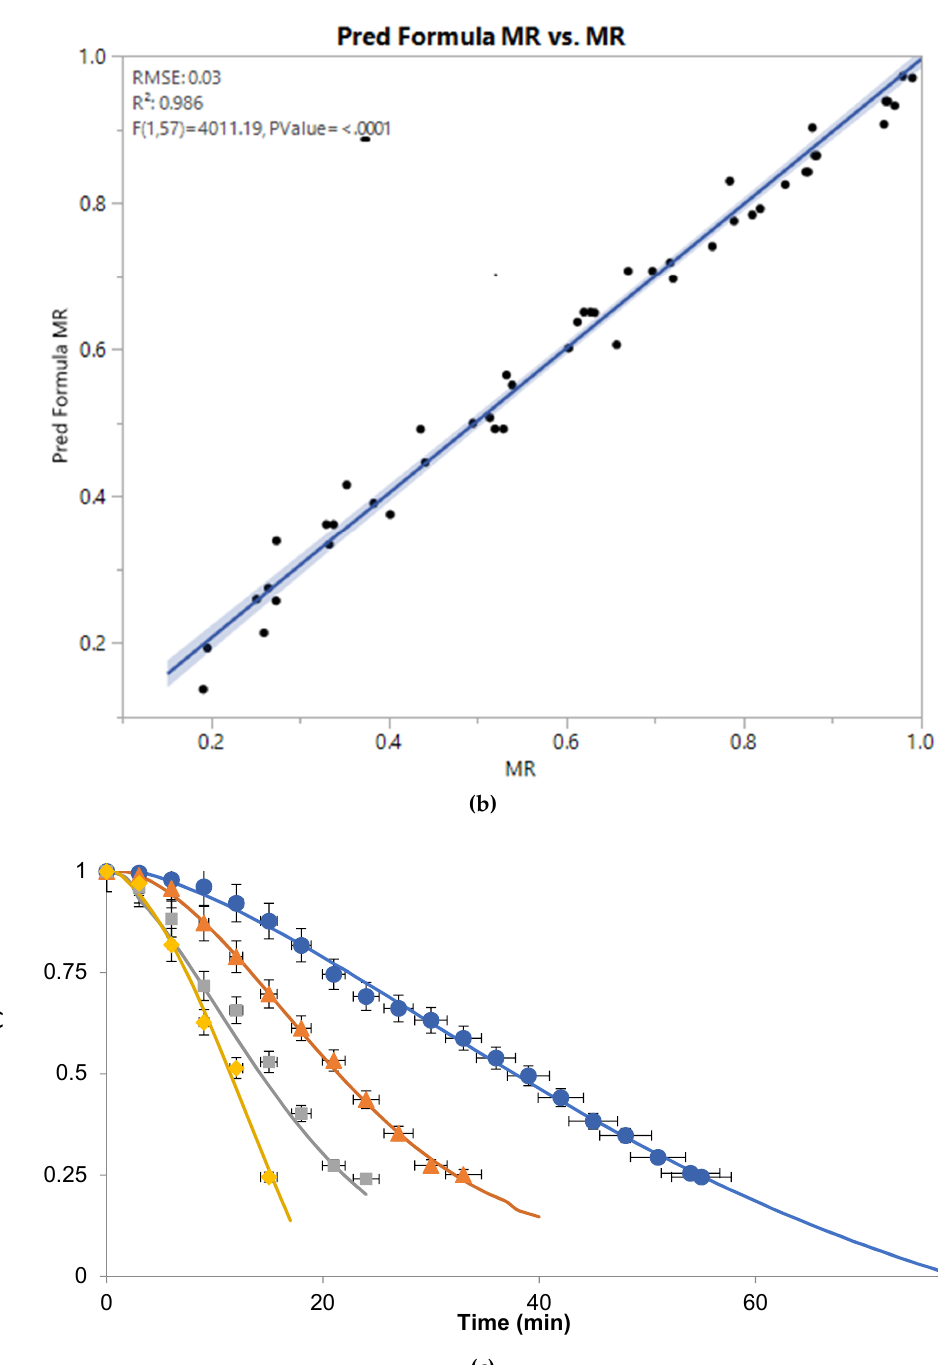
Figure 2. Response surface plot of moisture ratio (MR) as a function of time and power ( a ), comparison of experimental vs predicted MR ( b ), graphical representation of MR as a function of time at various microwave powers: (◊) 100 W, (□) 80 W, (Δ) 50 W, and ( ○ ) 30 W. Lines represent Midilli model for respective powers ( c ).